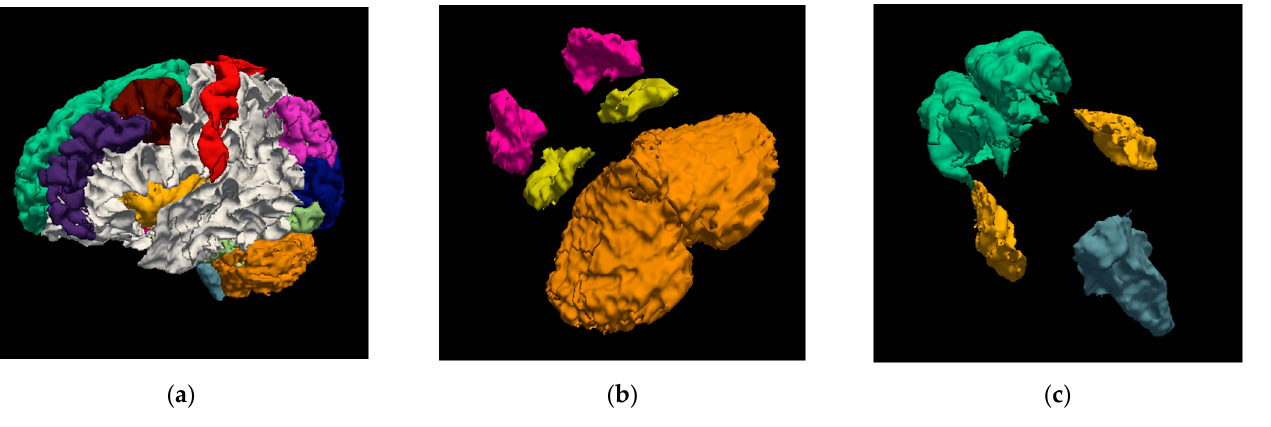
Figure 5. Segmentation results of the proposed architecture in 3D. ( a ) Segmentation of the 37 brain structures; ( b ) segmentation of the cerebellum cortex (orange), putamen (magenta), and hippocampus structures(yellow); ( c ) segmentation of the brain stem (gray), insula (yellow), and superior frontal structures (green).